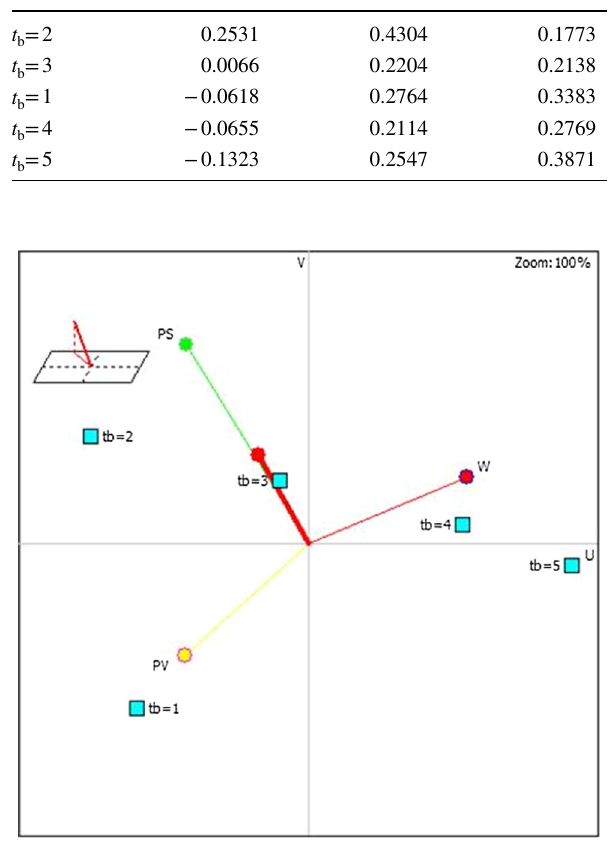
Table 3 Results obtained by using the method PROMETHEE Variant